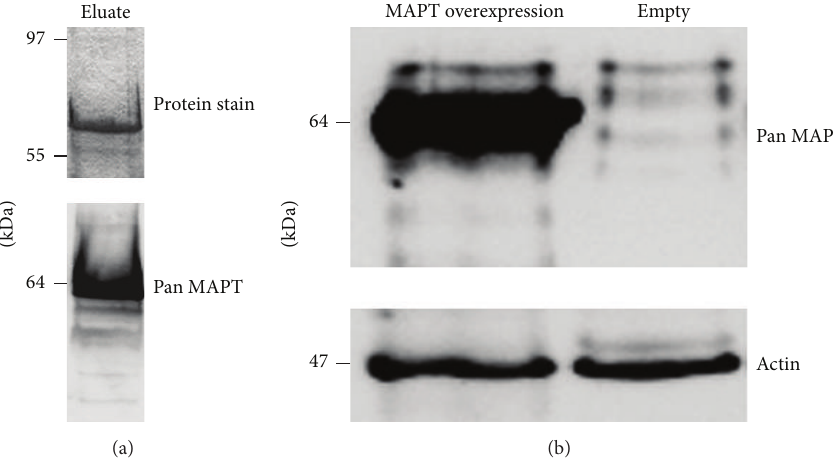
Figure 3: (a) Bacterial expression of MAPT isoform (3RD-MAPT3, 381aa). Ni-NTA purified human recombinant His-tagged MAPT visualized by Coomassie Blue staining (upper panel). The immunoblotting of recombinantly produced MAPT in BL21 E. coli visualized by the pan MAPT specific Ab (lower panel). (b) Overexpression of 3RD-MAPT3 in Rin-5F cells. The immunoblotting of MAPT overexpressing Rin- 5F cell line versus Empty Rin-5F cell line using a pan MAPT specific Ab. Densitometric measurements showed 10-fold stable overexpression of MAPT in the transgenic cell